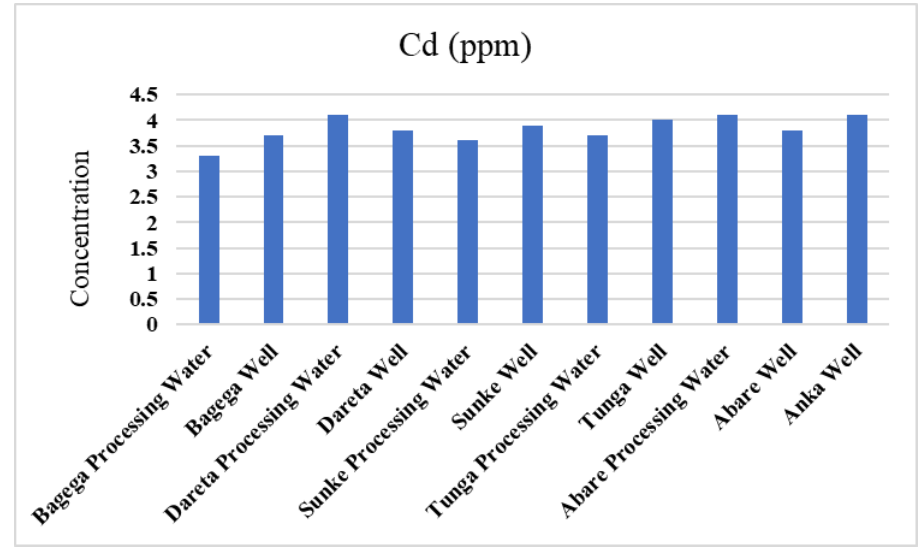
Figure 4. Mean cadmium (Cd) concentrations (ppm) in water samples of the study